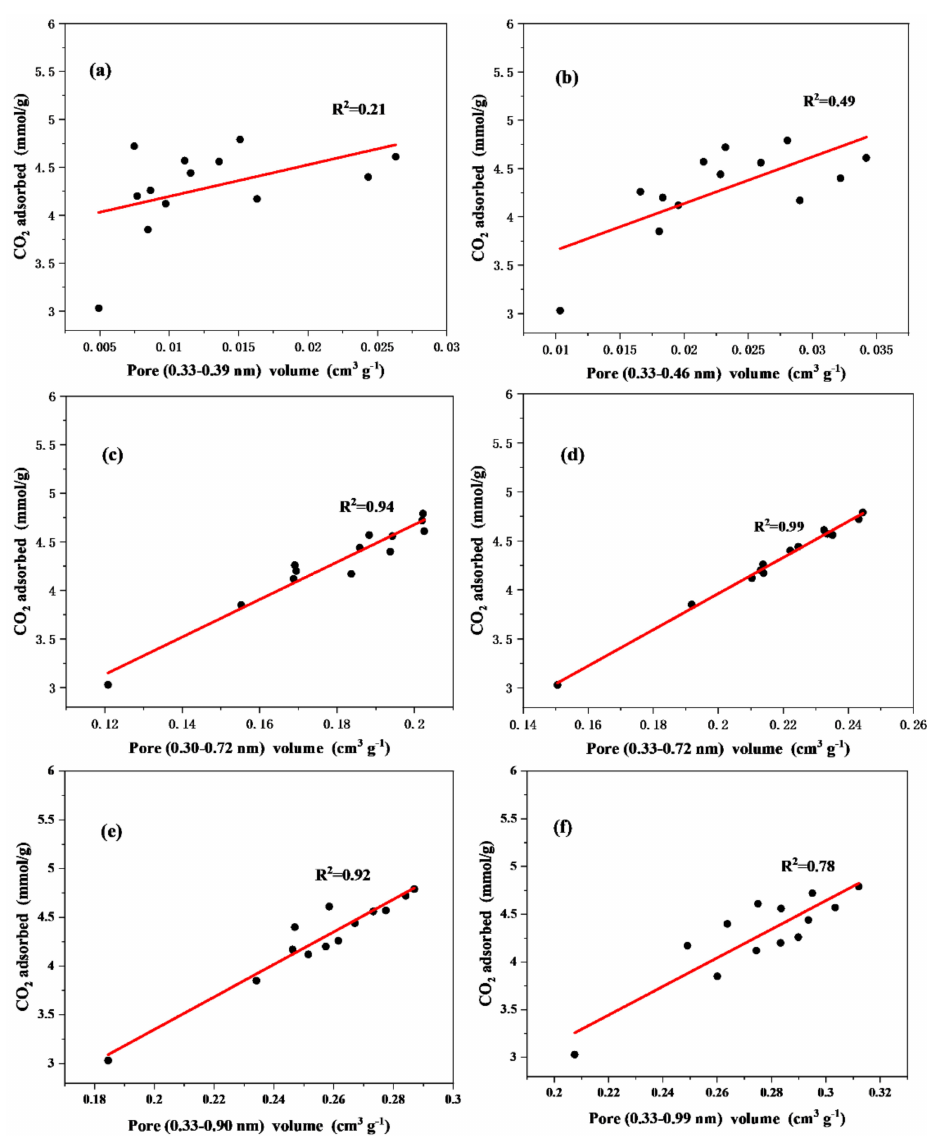
Figure 8. Relationship between CO 2 adsorption at 273 K and the volume of micropores in the range of ( a ) 0.33 − 0.39 nm, ( b ) 0.33 − 0.46 nm, ( c ) 0.33 − 0.72 nm, ( d ) 0.33 − 0.82 nm, ( e ) 0.33 − 0.90 nm, and ( f ) 0.33 − 0.99